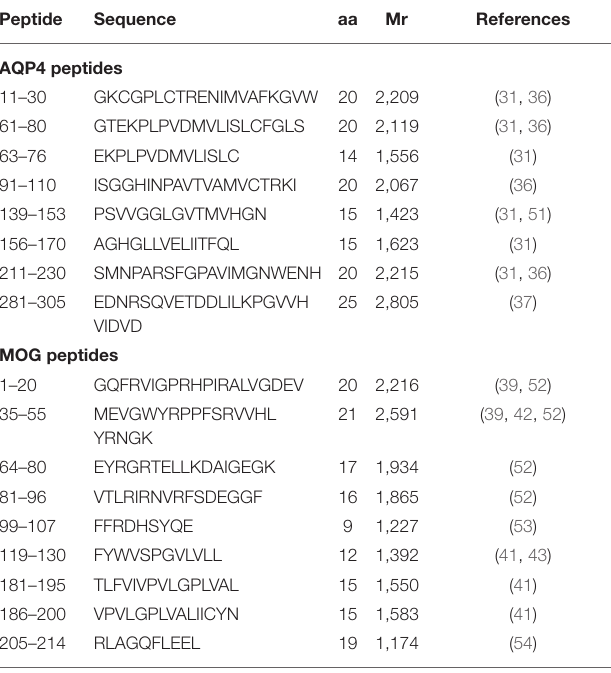
TABLE 2 | AQP4 and MOG peptides used for CD4 + T-cell stimulation. Peptide